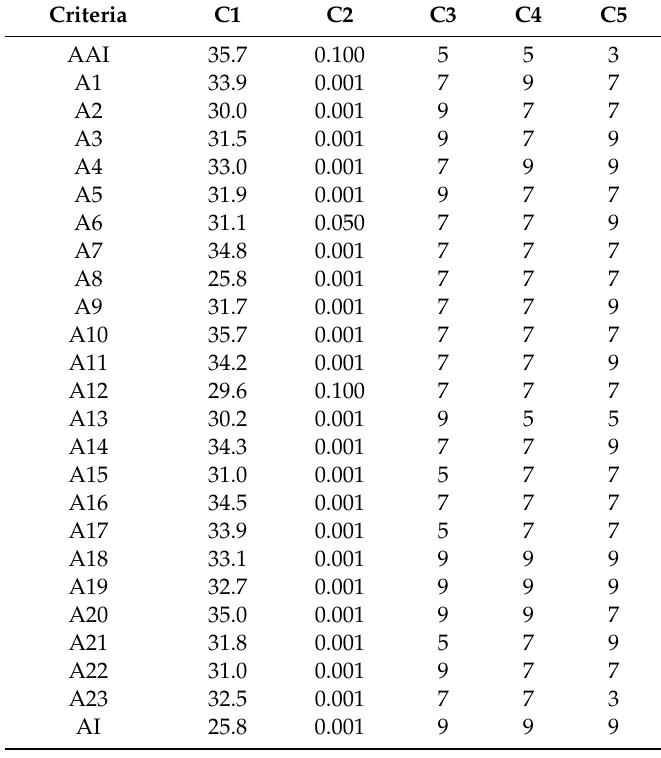
Table 2. Extended initial decision matrix.